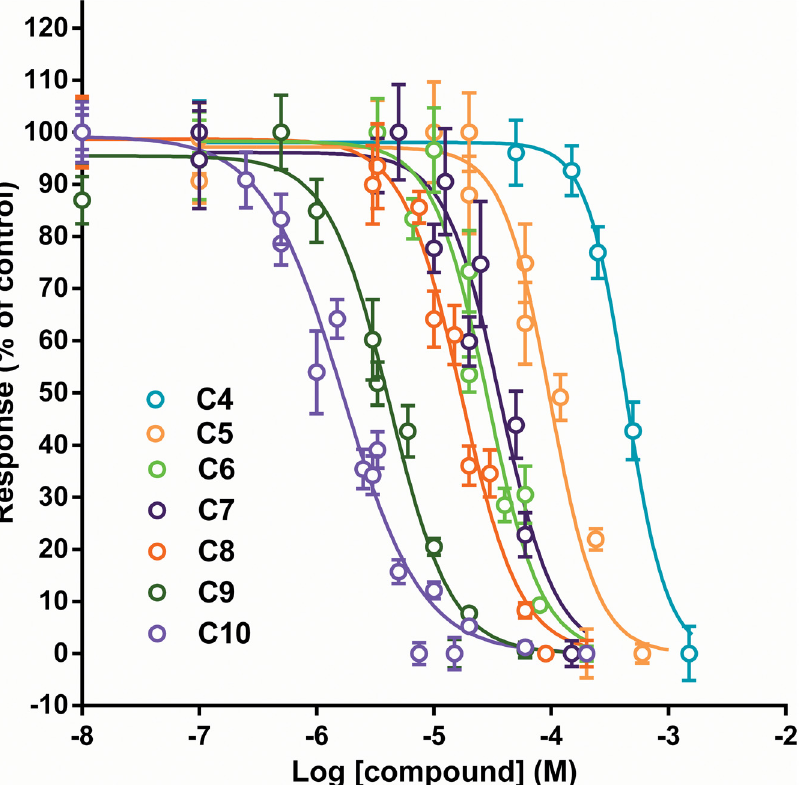
Fig 6. Influence of linker length on the effect of the test compounds in SH-SY5Y cells. The Ca 2+ response to nicotine (50 μ M) was measured in SH-SY5Y cells using a Fluostar Optima plate reader. Data are displayed as the mean ± SEM of two experiments with eight replicates on each plate. Curves were fitted were fitted with a standard four parameter logistic equation (see text).